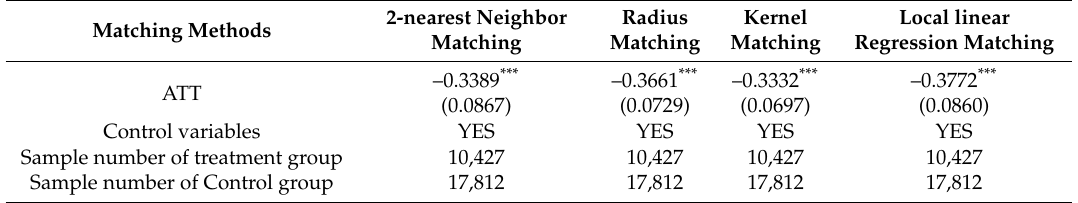
Table 9. Internet use and medical service satisfaction (propensity score matching).